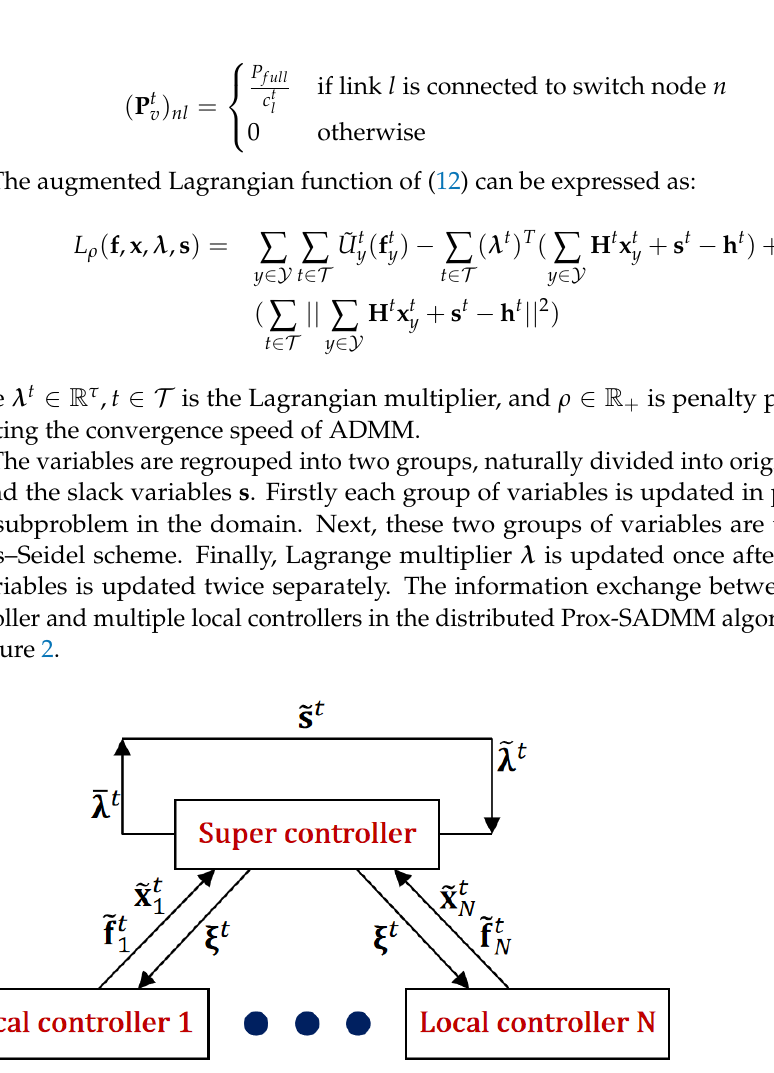
Figure 2. Diagram for the distributed